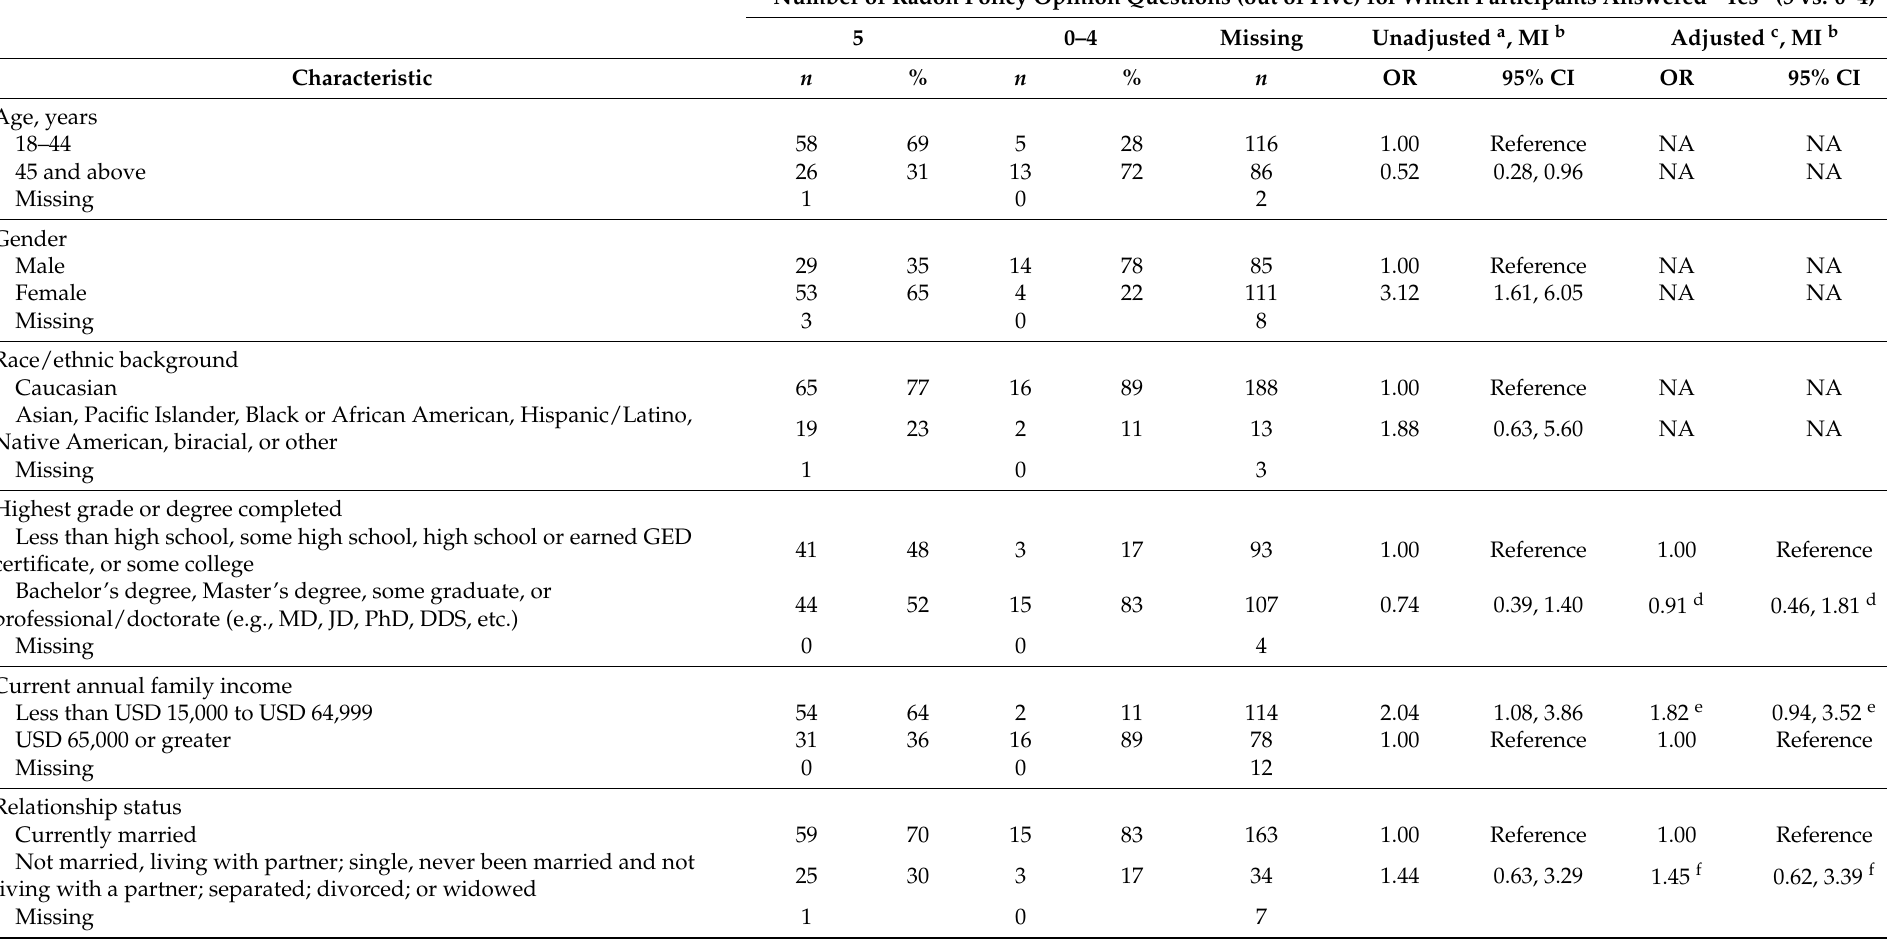
Table 7. Unadjusted and adjusted, multiply imputed associations between characteristics and number of radon policy opinion questions (out of five) for which participants answered “Yes” among radon testing survey participants, Utah County, Utah, May 2014–January